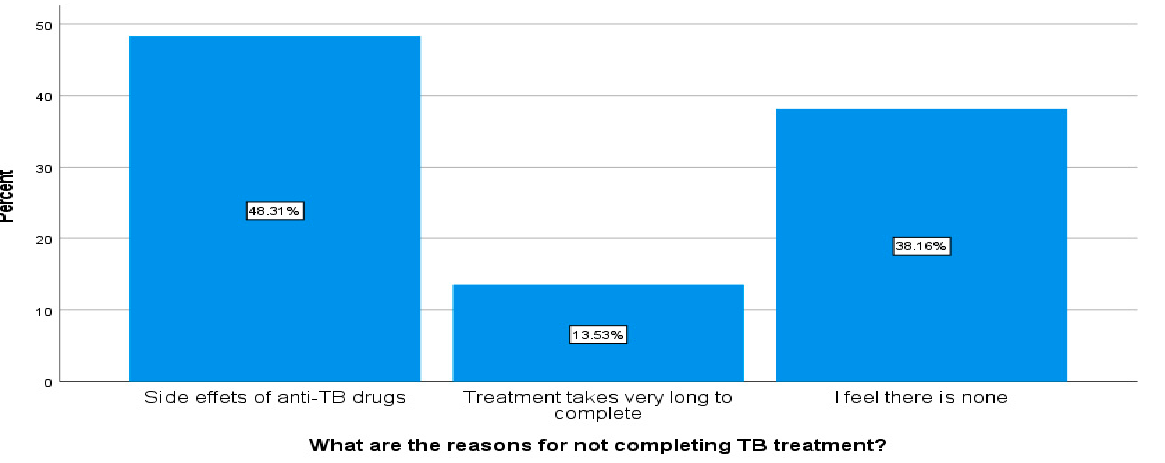
Figure 6. Exploring respondents’ perception for not completing TB treatment ( n = 207).